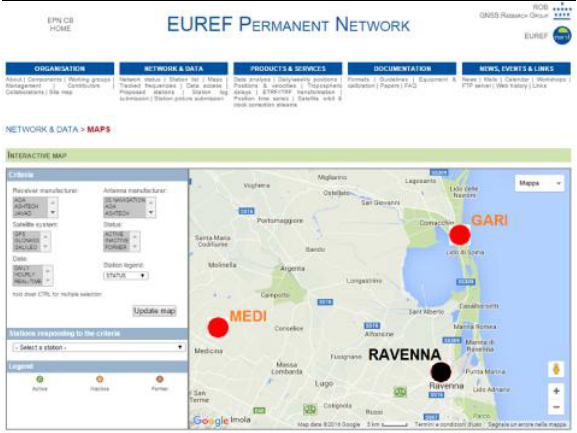
Figure 4. The EUREF GPS permanent stations in Medicina and Porto Garibaldi.